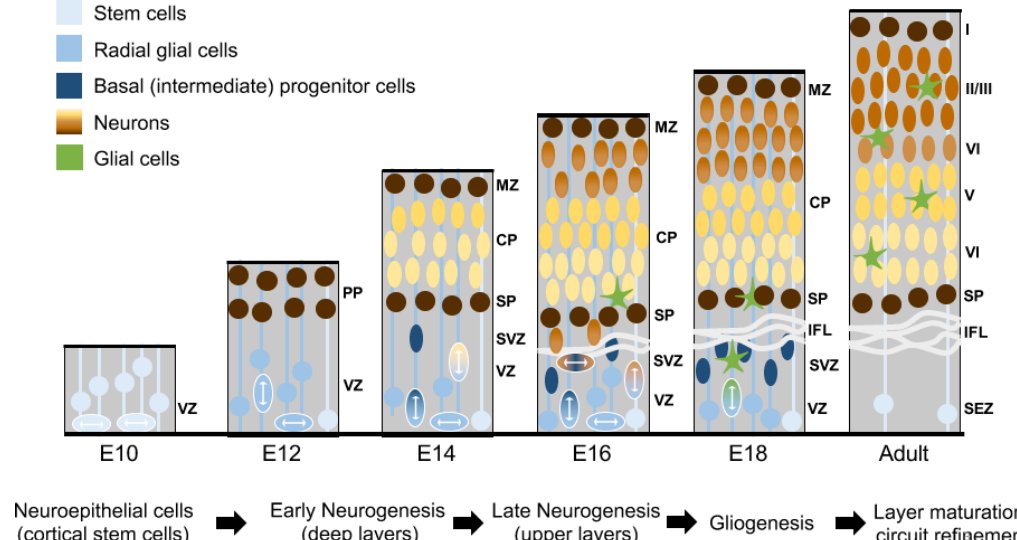
Figure 3. Development of the murine neocortex. At E10, neuroepithelial cells (white) in the ventricular zone (VZ) proliferate to expand the progenitor pool. By E12, neuroepithelial progenitors differentiate into radial glial cells (light blue). Radial glia begin to undergo self-renewing asymmetric divisions, producing neuronal precursors that contribute to the preplate (PP; dark brown). By E14, the preplate has split into the marginal zone (MZ) and subplate (SP). Subsequent waves of neurons migrate radially along basal processes of radial glia, and take up positions in the cortical plate (CP), settling in an inside out fashion: deep layers (yellow) are generated first and upper layers (light brown) begin to be generated later. By E14, some radial glial cells give rise to intermediate or basal progenitor cells, which in turn, are thought to divide in the subventricular zone (SVZ) to give rise to pairs of daughter neurons (shown in dark blue). Radial glial cells transition from generating neurons to generating glial cells at around E16 (green). Gliogenesis, layer maturation, axonogenesis, dendritogenesis, and circuit refinement continues to unfold postnatally, ultimately yielding the mature six-layered neocortex. IFL: inner fiber layer, SEZ: subependymal zone. I–VI: neural layer I–IV.